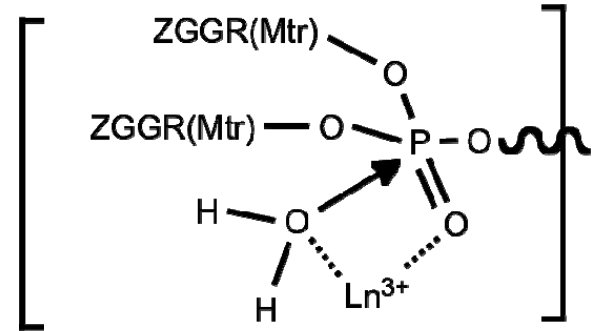
Figure 3. The intermediate during lanthanide-mediated dephosphorylation, which results in cleavage of the two peptide-phosphate bonds and the resin-phosphate